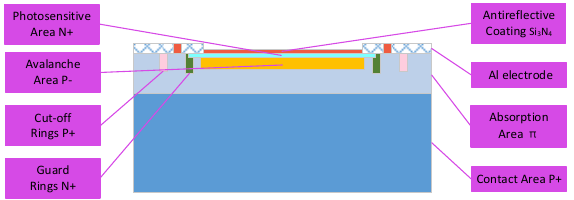
Figure 2. Cross-section of the Si-APD with a reach-through structure.